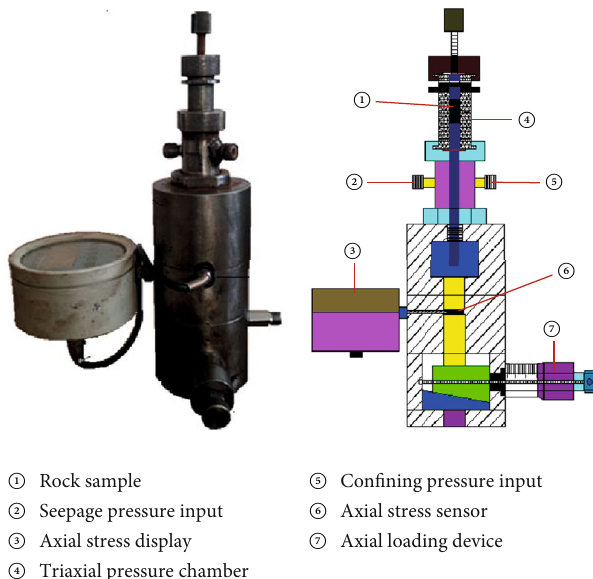
Figure 3: Mini triaxial seepage testing machine: ① rock sample, ② seepage pressure input, ③ axial stress display, ④ triaxial pressure chamber, ⑤ con fi ning pressure input, ⑥ axial stress sensor, and ⑦ axial loading